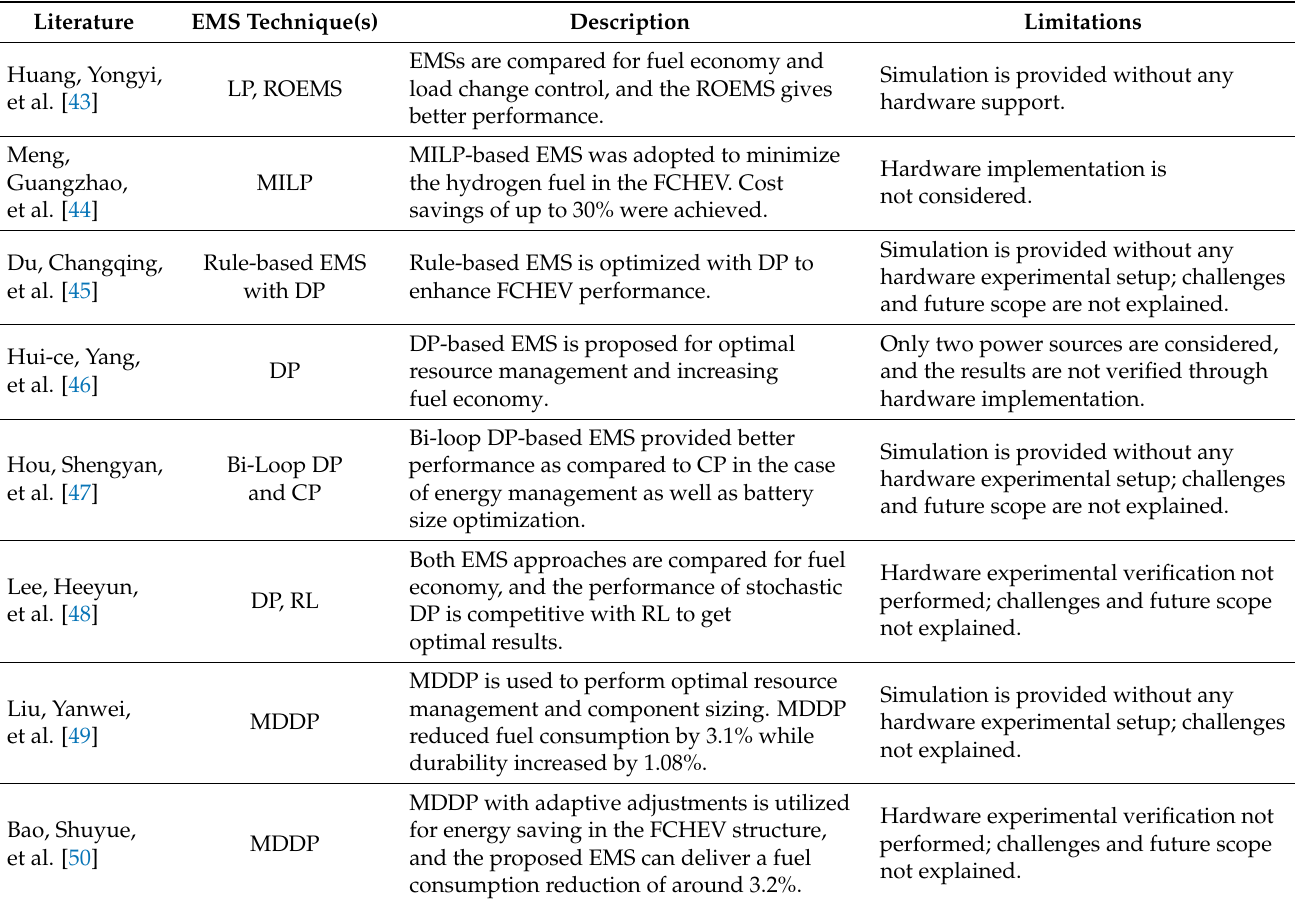
Table 3. Summary of the latest literature related to LP- and DP-based EMSs.